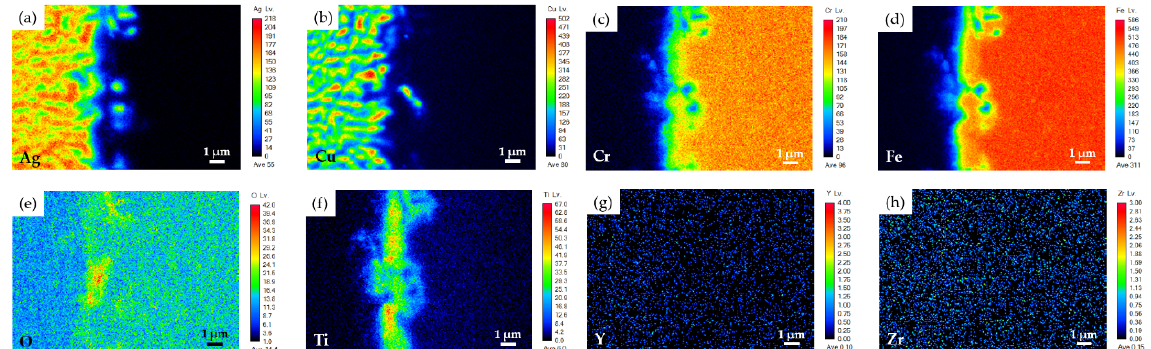
Figure 5. EPMA WDS element mappings of Crofer side in Figure 3d: ( a ) Ag, ( b ) Cu, ( c ) Cr, ( d ) Fe, ( e ) O, ( f ) Ti, ( g ) Y, and ( h ) Zr. ( e ) O, ( f ) Ti, ( g ) Y, and ( h ) Zr.